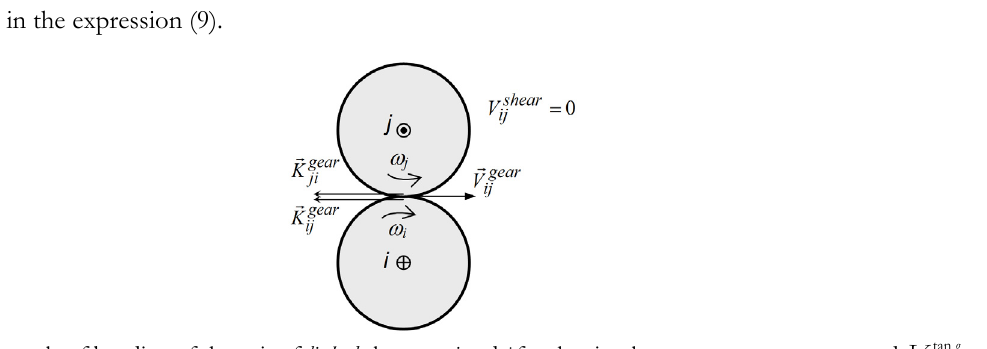
Figure 3: An example of bending of the pair of linked elements i and j for the simple case: 